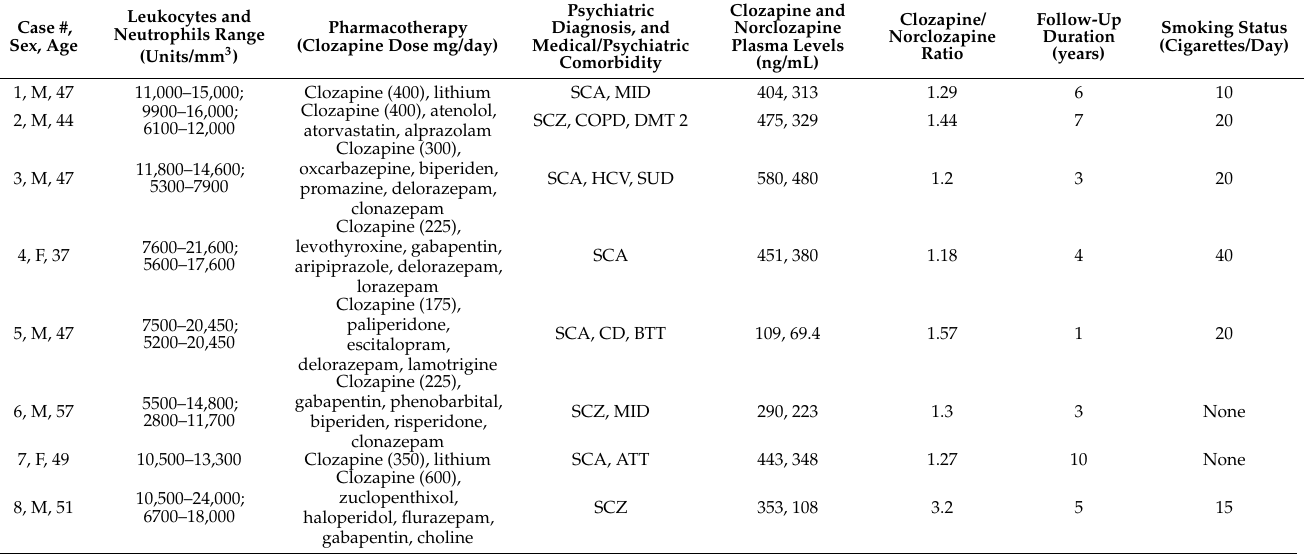
Table 2. Main clinical and treatment-related characteristics of reported cases of leukocytosis during